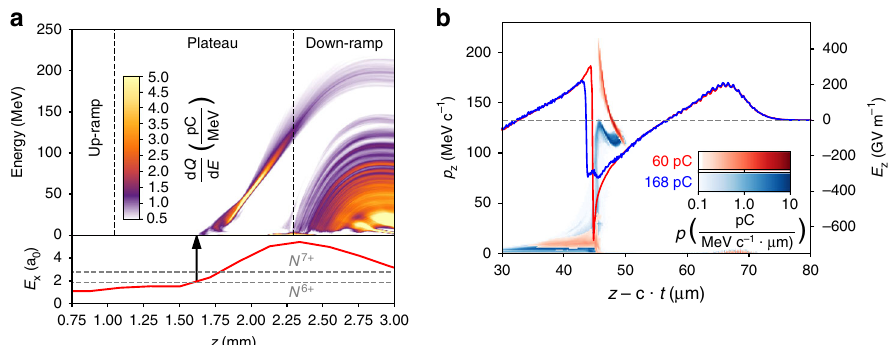
Fig. 4 Energy evolution and beam loading effects during the acceleration process. Results from PIC simulations. a Energy histogram ( top ) showing evolution of the electron energy throughout the acceleration process. Final injected charge in the peak is 60 pC. The bottom plot shows the on-axis laser strength evolution with the dotted lines representing the required fi eld for ionization of the two nitrogen K-shell electrons. Additional injection of both helium and nitrogen electrons occurs in the density down-ramp of the gas jet, resulting in a low-energy background in the fi nal energy spectrum. b The effect of beam loading on the accelerating fi eld E z ( line graphs , right axis ) and electron phase space ( color scale , left axis ) for 60 pC load in the peak ( red ) and 168 pC load ( blue ). Corresponding to z = 2.3 mm in a